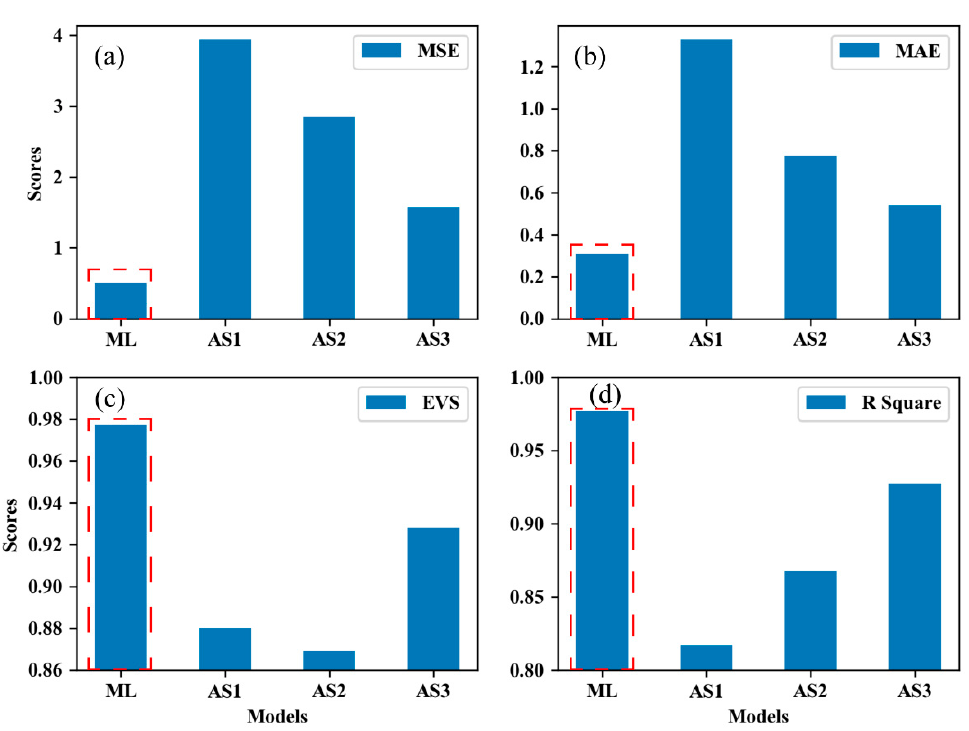
Figure 6. Comparison of the accuracy of results from different gravity sampling penetration depth prediction models. ( a ) Comparison of MSE of prediction results of four models; ( b ) comparison of MAE of prediction results of four models; ( c ) comparison of EVS of prediction results of four models; ( d ) comparison of R 2 of prediction results of four models. ML is the machine learning model, AS1 is analytical solution model 1, AS2 is analytical solution model 2, and AS3 is analytical solution model 3. The smaller the value of MSE and MAE , the higher the accuracy. The larger the EVS , the higher the accuracy. The closer R is to 1, the better the prediction result. The red dashed line denotes the best performance value for each performance metric.